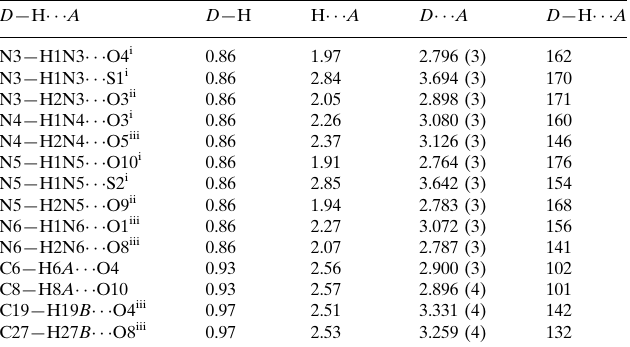
Hydrogen-bond geometry (A˚ , (cid:3)